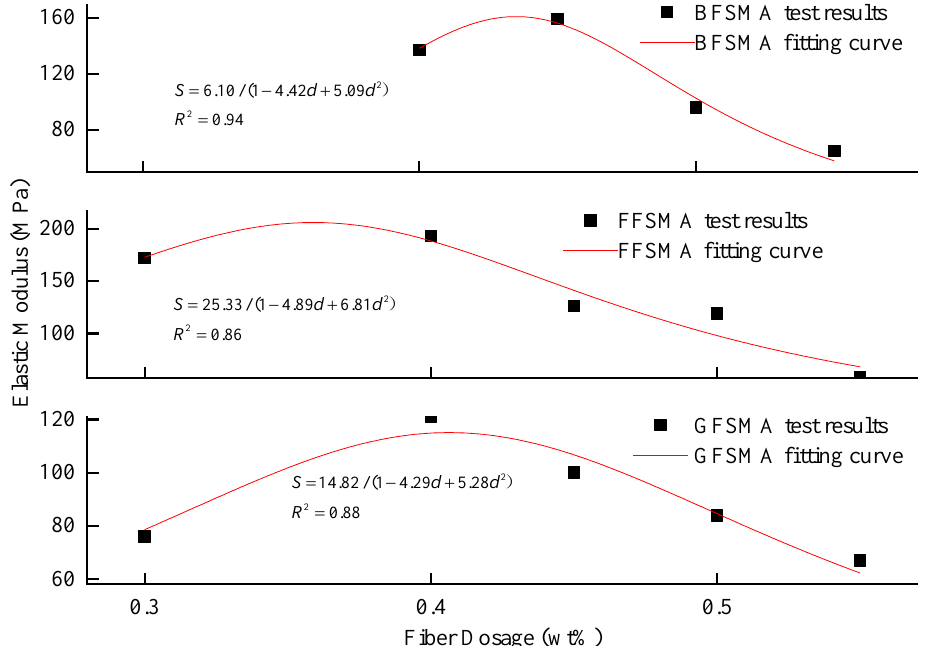
Figure 10. Fitting between fiber dosage and elastic modulus.